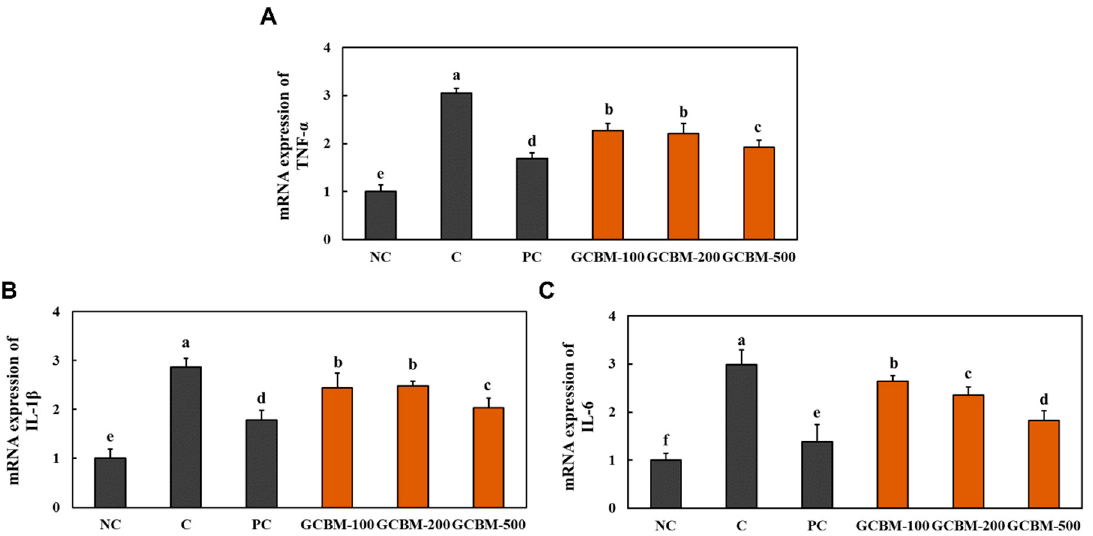
Figure 2. Effects of GCBM on the mRNA expression of TNF- α ( A ), IL-1 β ( B ), and IL-6 ( C ) in the dorsal skin of UVB irradiation-induced photoaging in mice. Normal control (NC), control (C; UVB-irradiation), positive control (PC; UVB-irradiation with diet containing L -ascorbic acid at 100 mg/kg/body weight [b.w.]), GCBM-100 (UVB-irradiation with dietary supplementation of GCBM at 100 mg/kg/b.w.), GCBM-200 (UVB-irradiation with dietary supplementation of GCBM at 200 mg/kg/b.w.), and GCBM-500 (UVB-irradiation with dietary supplementation of GCBM at 500 mg/kg/b.w.). Values are presented as mean ± SD. Different letters (a > b > c > d > e > f) indicate a significant difference, with 𝑝 < 0.05, as determined with Duncan’s multiple range test.